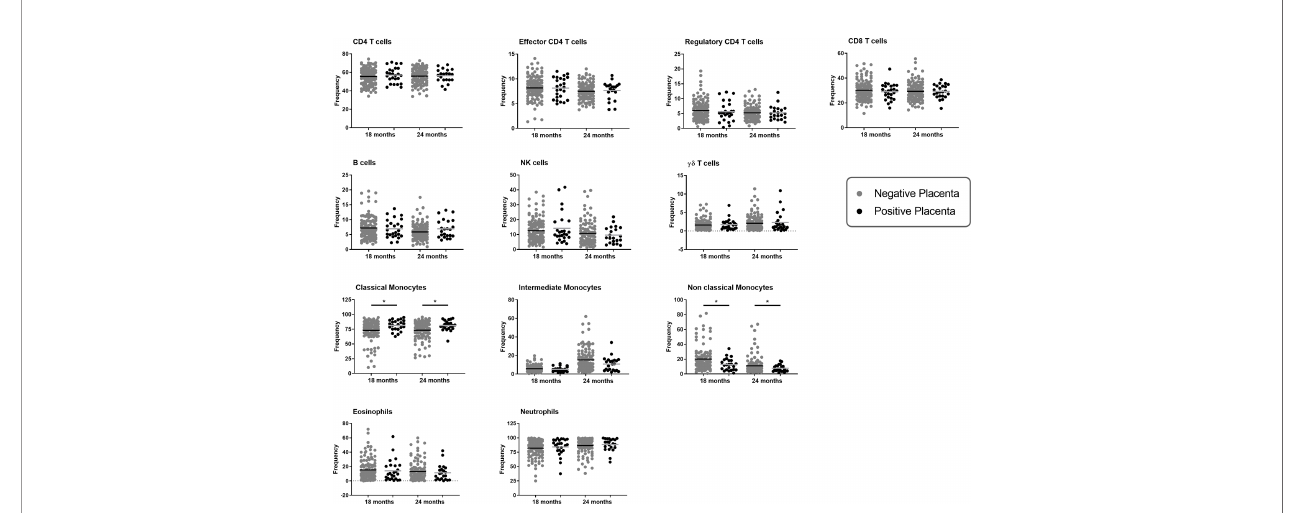
FIGURE 2 | Immune cell populations at 18 and 24 months of age according to placenta malaria. The frequency of each immune cell population at either 18 or 24 months of age was represented in one graphic. Cell subset frequencies were determined as followed: CD4, CD8 and gd T cells among total CD3 + T cells; regulatory and effector CD4 + T cells among CD4 + CD3 + T cells; Monocyte subsets among total monocytes, B or NK cells among lymphoid cells and neutrophils or eosinophils among granulocytes gated using forward- and side-scatter properties. The frequency of immune cells in infants born form mother with or without placental malaria are represented in gray and dark plain round respectively. The horizontal dark line in the beeswarm plot represents the median value. A linear regression was performed to compare the frequencies between the two groups of infants (infants born from a mother with an active placental malaria infection (n=27) vs infants born from a mother without placental malaria infection (n=127)). *: p value lower than 0.05 (and higher than